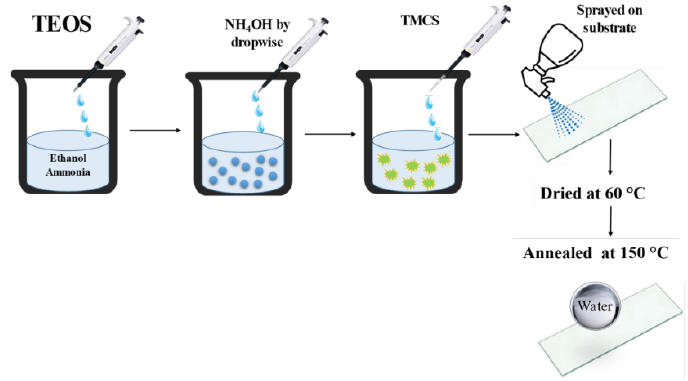
Figure 1. Preparation of superhydrophobic SiO 2 /TMCS coatings onto glass.